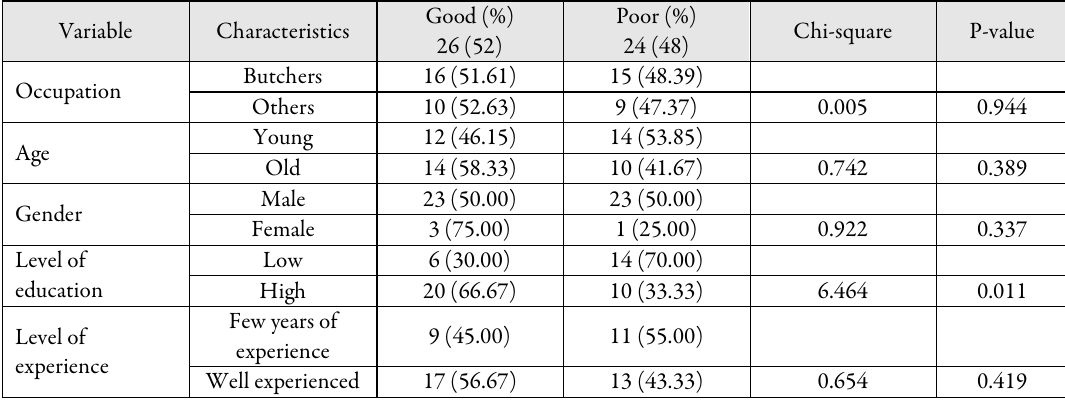
Table 5. Factors influencing behaviours that expose to ZTB among workers in Ikpa